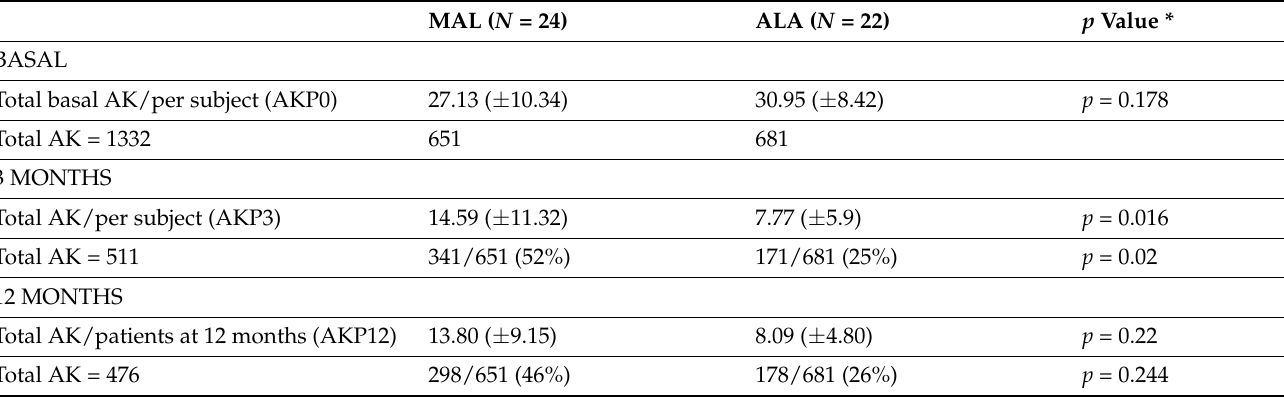
Table 2. Summary of the comparative results per patient and total lesions.